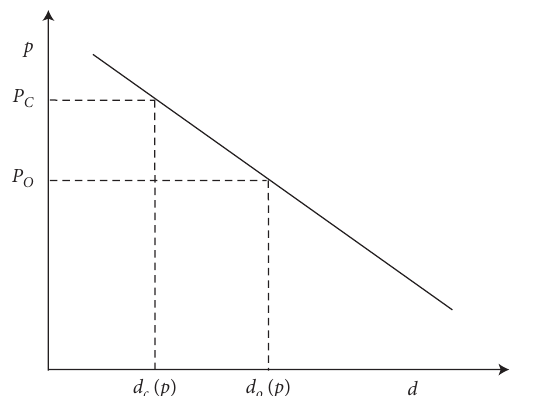
Figure 1: Market demand in differential pricing of cold chain agro-